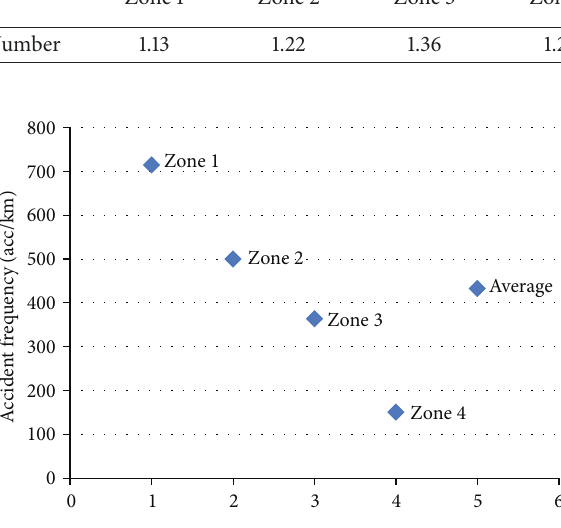
Figure 6: Spatial distributions of traffic accidents.